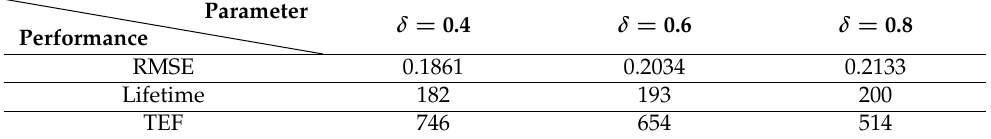
Table 6. The effect of different δ values on the performance of WSNs, when α = 0.3 and δ = 0.8.